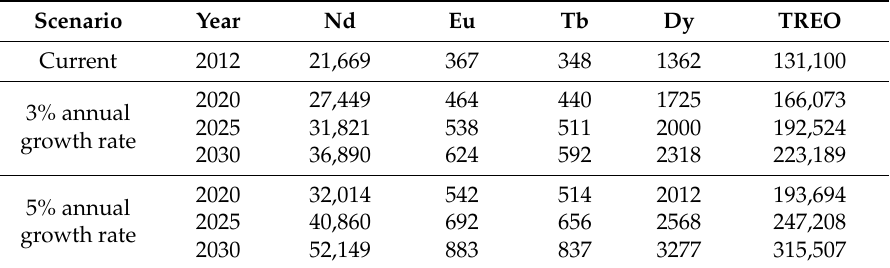
Table 3. Global REE production at 3% and 5% annual growth